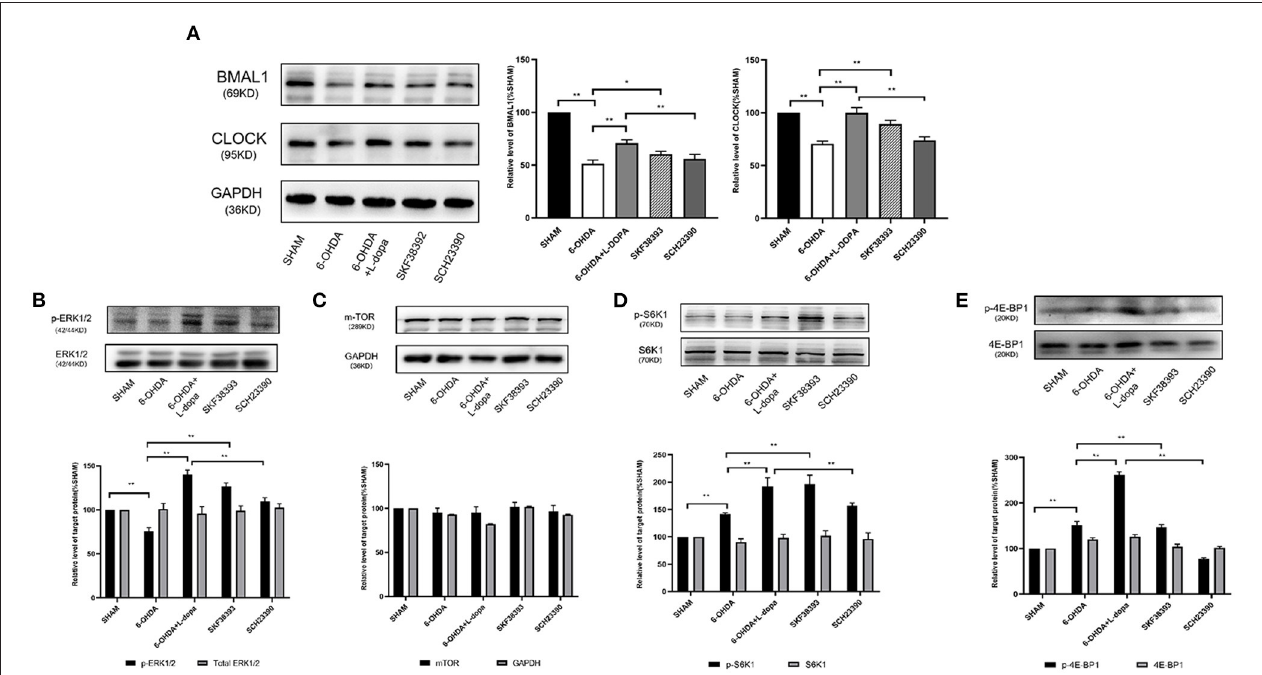
FIGURE 6 | The effect of selective D1R agonist/antagonist on clock protein and downstream signaling. (A) The expressions of BMAL1 and CLOCK protein among five groups. Statistical analysis of the relative level of BMAL1 and CLOCK of sham saline-lesioned side. (B–E) The expression of ERK1/2, downstream effector of mTOR, and its phosphorylation levels among five groups. Western blot and statistical analysis of total ERK1/2 and phosphorylation of ERK1/2, mTOR, total S6K1 and phosphorylation of S6K1, as well as total 4E-BP1 and phosphorylation of 4E-BP1. * p < 0.05, ** p < 0.01; n = 3–5 each